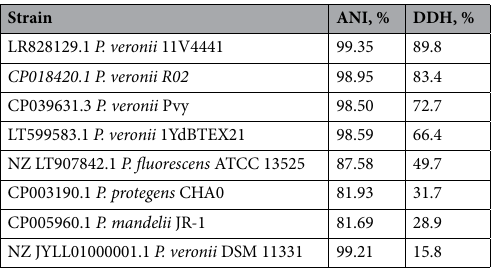
Table 1. ANI and DDH values of the P. veronii 7–41 and related strains.